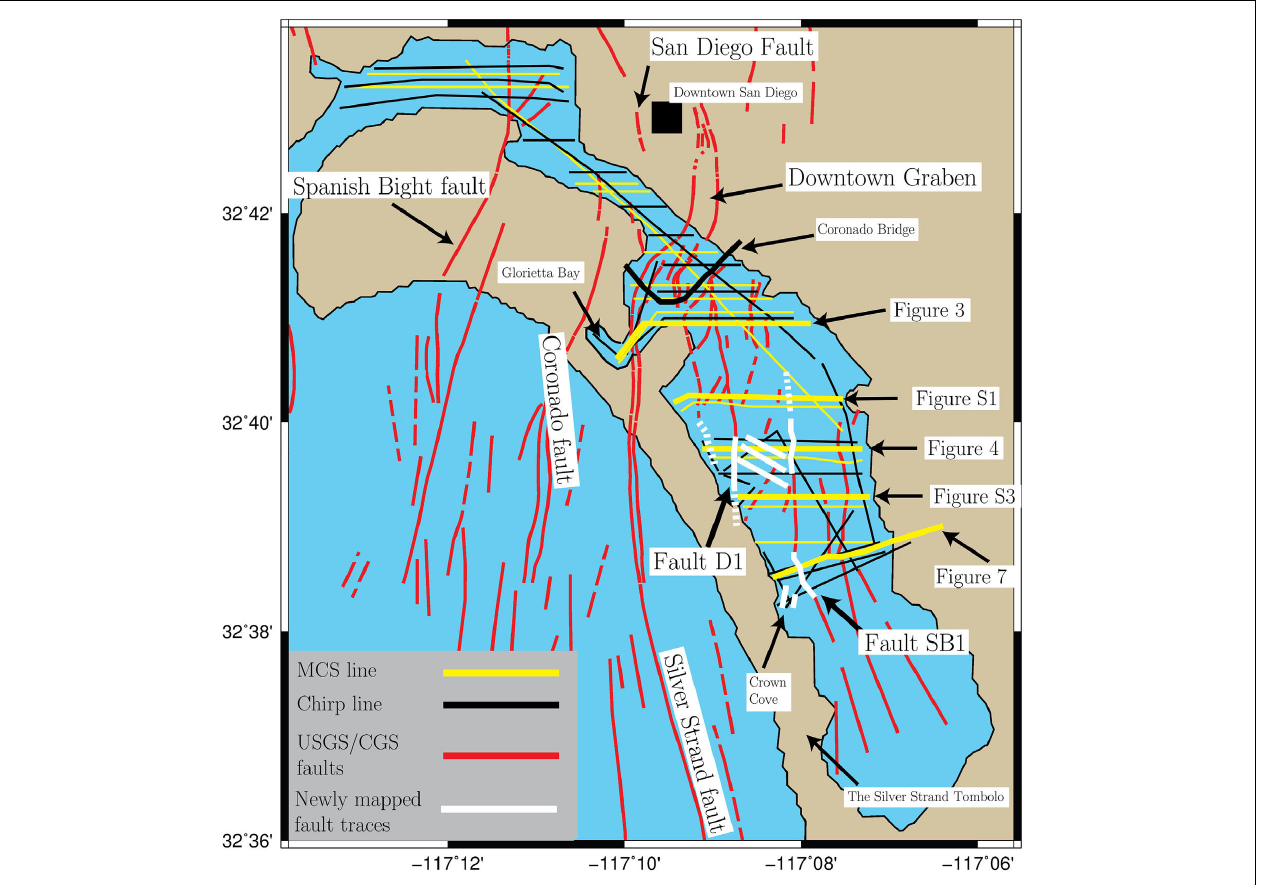
FIGURE 2 | Map of San Diego Bay showing previously mapped fault traces from USGS Quaternary fault database (red lines) (USGS, 2019), seismic data used in this study (yellow and black lines), and extended fault traces as part of this study (white lines). Bolded seismic lines are the location of figures presented in the text. Dashed red fault lines are older Quaternary fault traces, dashed white fault traces are obscured, but inferred fault traces. Figure created using Generic Mapping Tools (Wessel et al.,